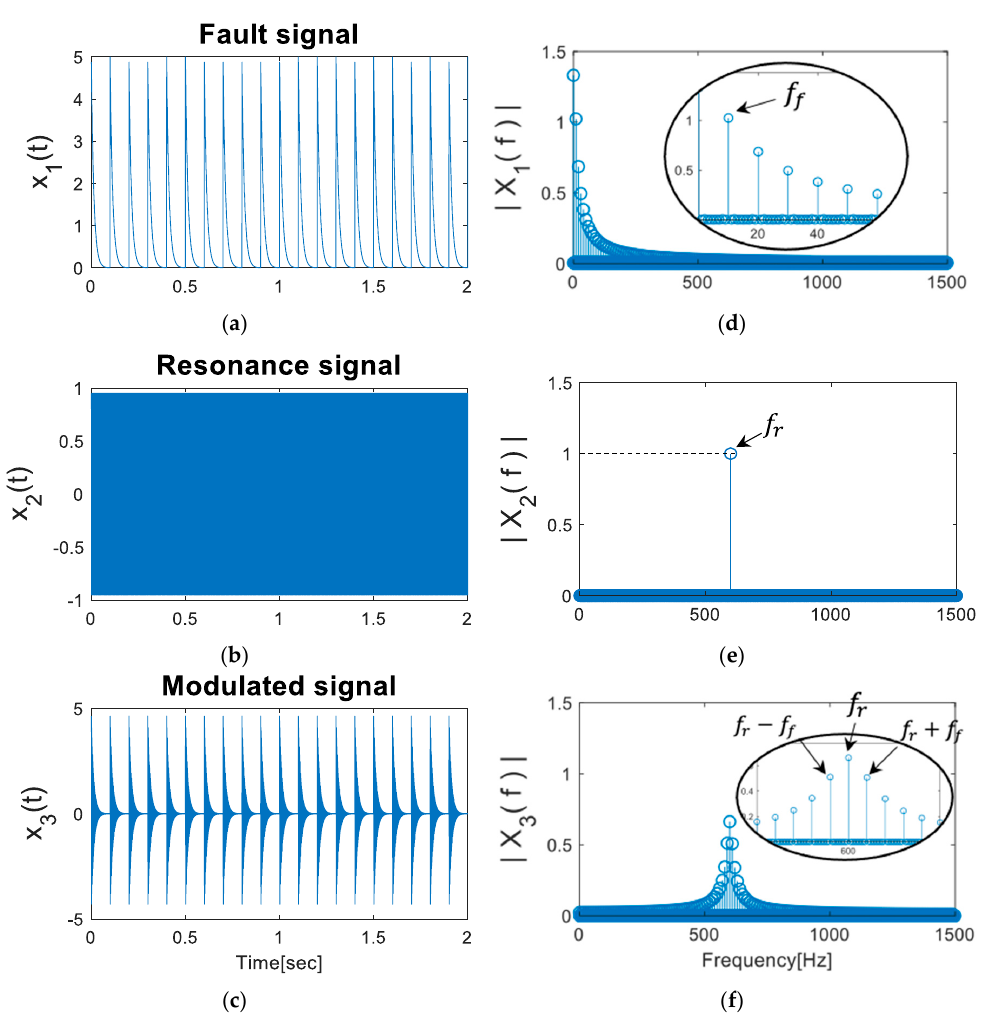
Figure 3. Modulation of simulation fault signal: ( a ) fault signal, ( b ) resonance signal, ( c ) AM signal, in the time domain; ( d ) fault signal, ( e ) resonance signal, ( f ) AM signal, in the frequency